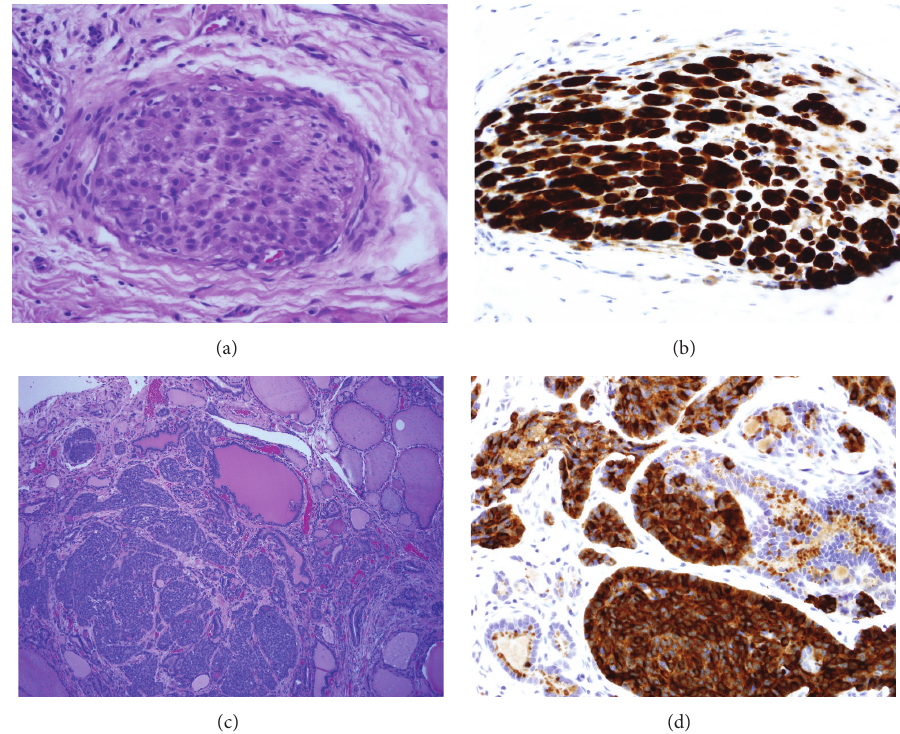
Figure 1: Tumor bed of laryngectomy and thyroid tumor, H&E stain and calcitonin immunostains. (a) H&E stain × 400: tumor bed, laryngectomy: solitary nerve twig infiltrated by plump epithelioid tumor cells. (b) Calcitonin immunostain × 400: tumor bed, laryngectomy: the infiltrating tumor cells are strongly immunoreactive for calcitonin. (c) H&E stain × 100: thyroid, right lobe nodule: 4 mm tumor nodule (left) adjacent to pink colloid-filled thyroid follicles (right). (d) Calcitonin immunostain × 400: thyroid: tumor cells are strongly reactive for calcitonin and can be seen focally invading into benign thyroid